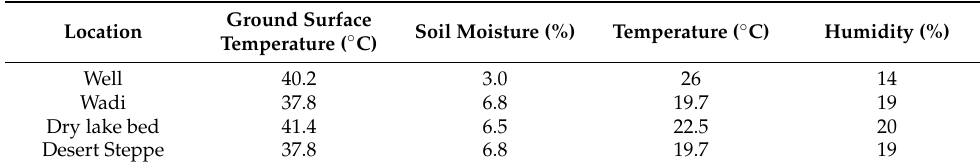
Table 1. Table 1. Environmental information at the observation